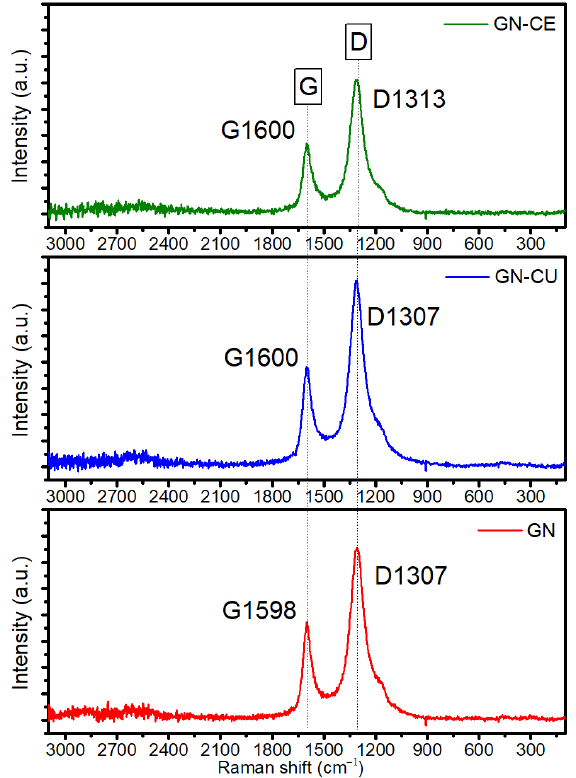
Figure 6. Raman spectra of GN, GN–CU and GN–CE .